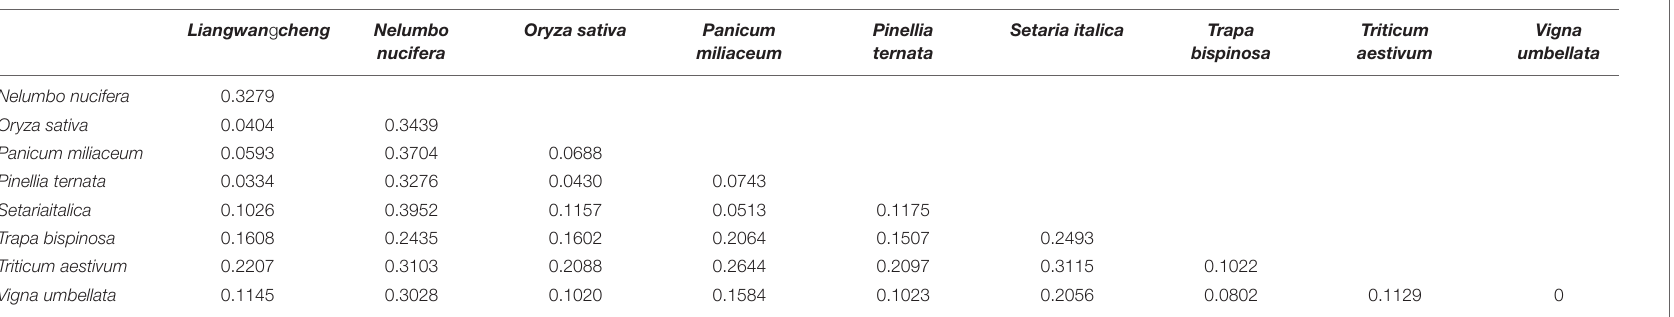
TABLE 3 | Procrustes distance matrix of Liangwangcheng and control